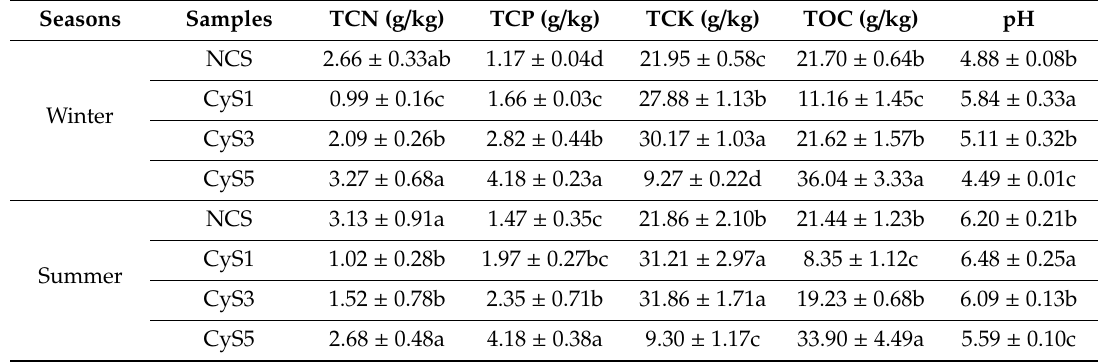
Table 1. Physicochemical characteristics of the rhizospheric soil in two seasons (winter and summer). Seasons